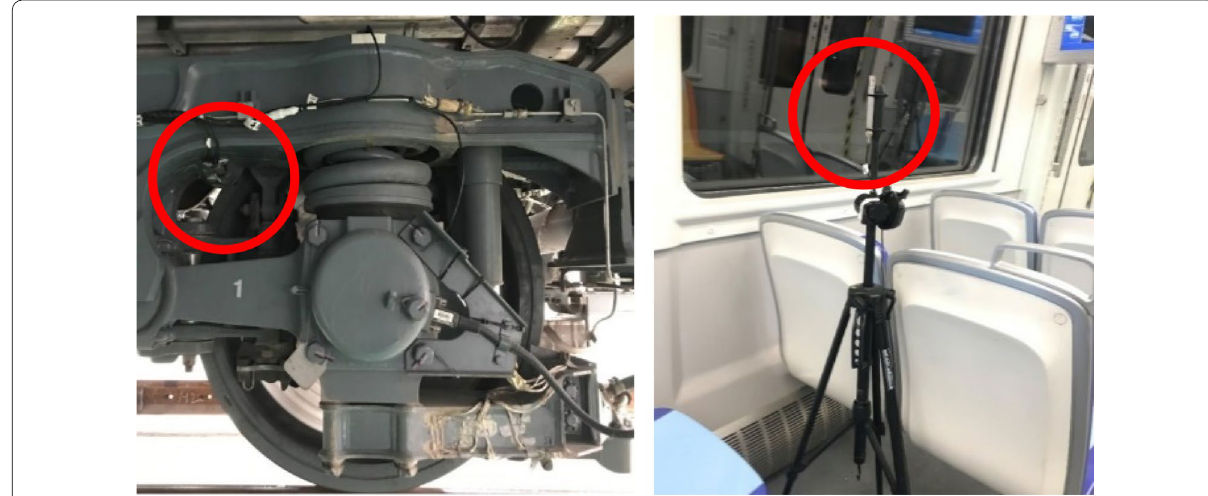
Figure 2 Wheel-rail noise and interior noise measurement